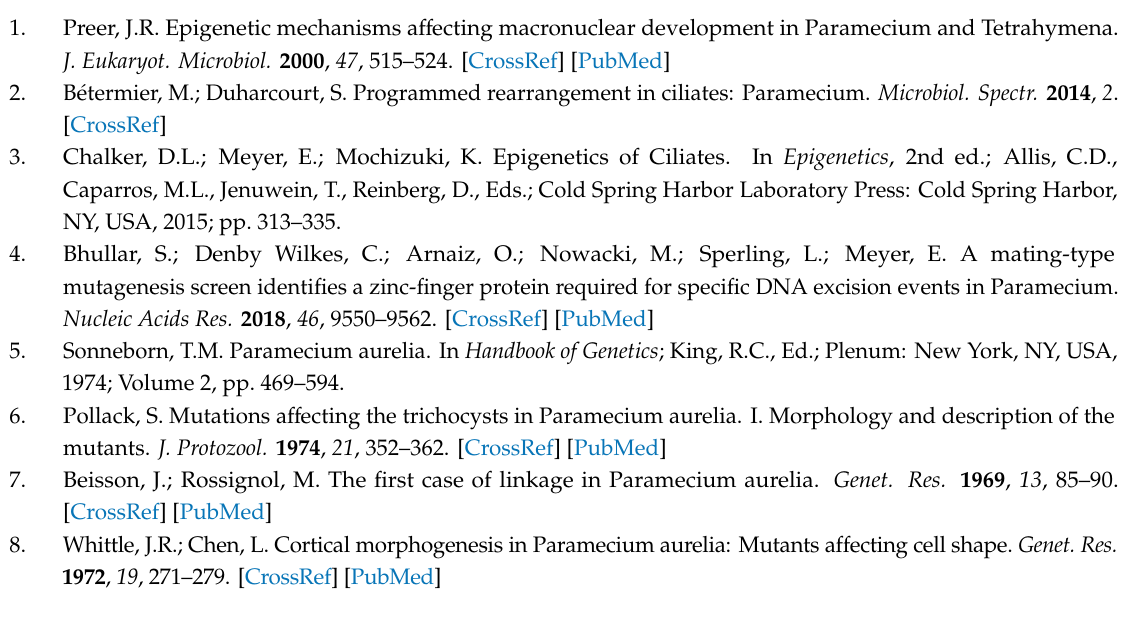
Figure S1: The origin of the Spinning Top mutant, Figure S2: Results of PCR demonstrating absence of the Spade gene in screwy mutants, Figure S3: Various deletions in the Spinning Top locus induced by dsRNA feeding, Figure S4: Shape of trichocysts in P. tetraurelia wild type and sc1-c 3 mutant cells. Table S1: Primers used for preparation of the feeding inserts, Table S2: Primers used for chromosome walking and for MIC-specific PCRs, Table S3: Genes from the MAC sca ff old51_77 segment deleted in the Spinning Top mutant. Video S1: wild-type P. tetraurelia strain 51 phenotype, Video S2: Spinning Top mutant